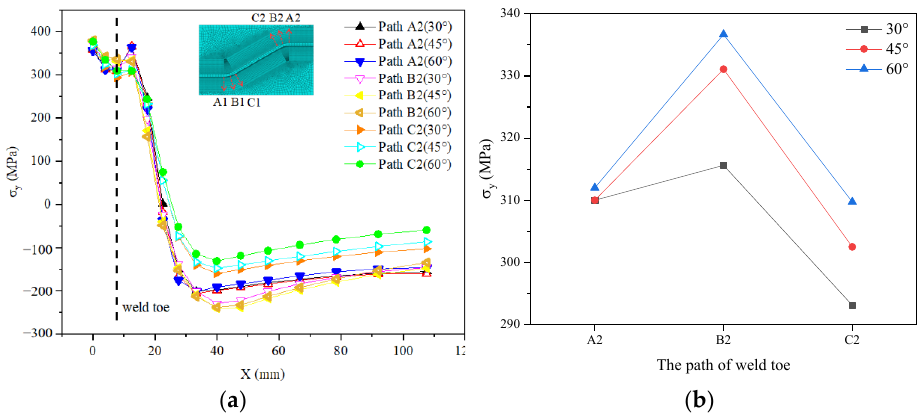
Figure 22. Residual stress distribution of longitudinal path front weldment. ( a ) Along the path direction; ( b ) Position of weld toe.